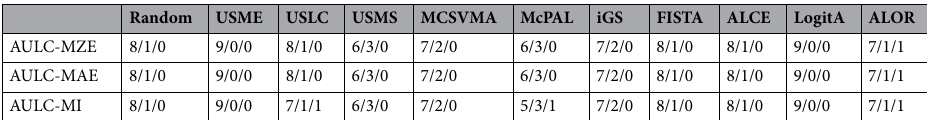
Table 3. Win/tie/loss counts of the proposed method versus the baseline methods based on the Wilcoxon signed-rank test at a 5% confidence